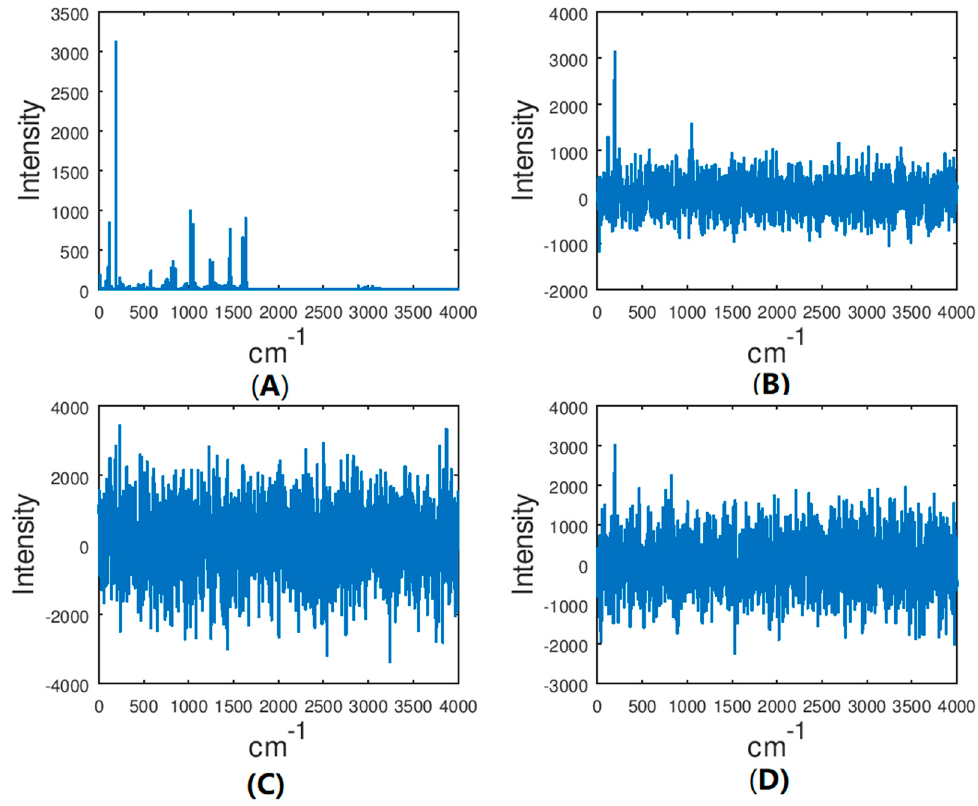
Figure 3. The IR spectrum of A232 computed at the B3LYP/anharmonic/6-311G+(2d,2p) level and summed with the white noise of amplitudes (clockwise from top left) ( A ) 0, ( B ) 500, ( C ) 1000, and ( D ) 1500.